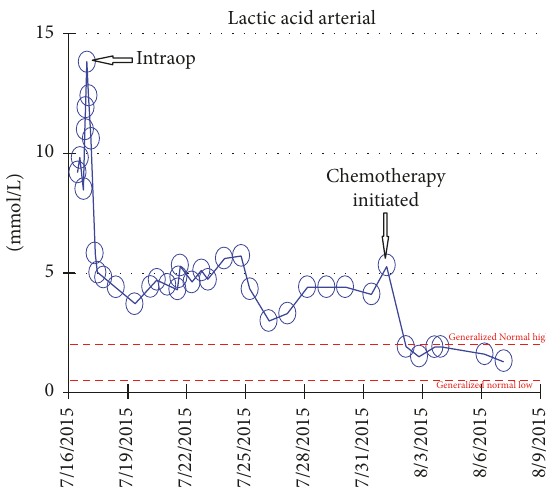
Figure 4: Lactic Acid Level